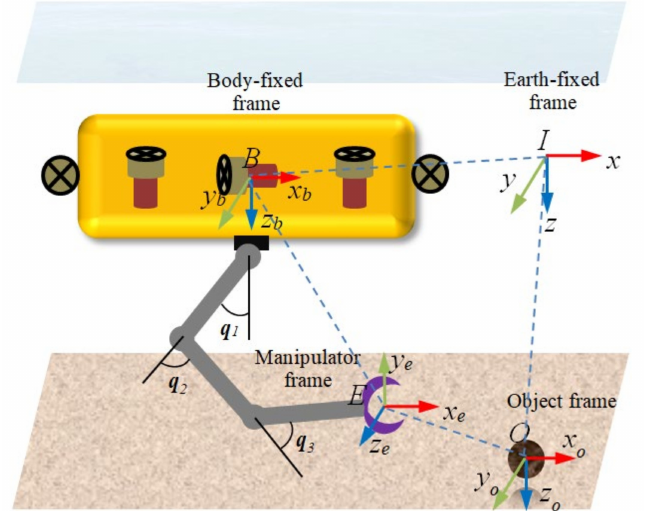
Figure 2. The model of UVMS equipped with a series manipulator and its coordinate